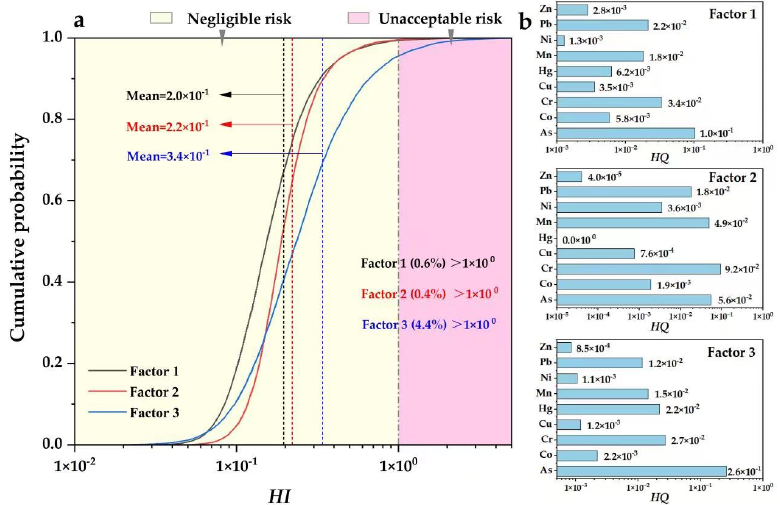
Figure 6. Probabilistic non-cancer risk of source-specific for children. ( a ) Cumulative probability of